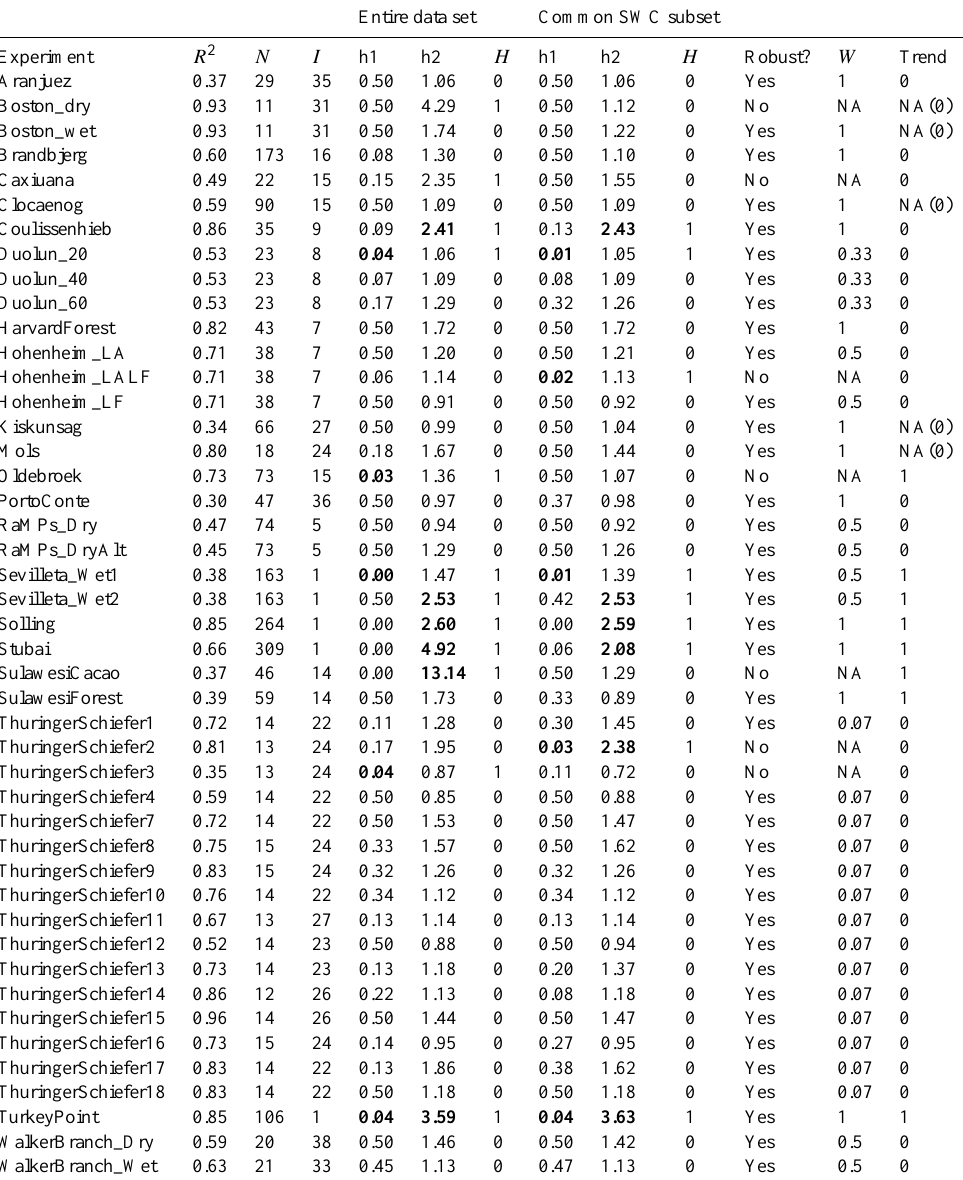
Table C1. For each experiment, we present the R 2 of the model fitted to the data of the control plots, the number of data points (N) and the median interval (in days) between two consecutive measurements of soil CO 2 efflux (I). We also show the results of the two tests that we performed to test our hypothesis. For both the entire data set and the common SWC subset, “h1” is the p value of the Lilliefors test for normality, “h2” shows the ratio of RMSE treatment to RMSE control and “H” indicates whether or not H1 was rejected (see Fig. 2 and Methods for details). Experiments for which both the entire data set and the common SWC subset gave the same result are indicated with “yes” in the column “Robust?”. The weight ( W ) used in this CART analysis is given ( W is calculated as 1/number of experiments per site that are used in CART). The results of the trend analysis on the time course of the predictability index of SCE treatment (Pi, runs test dichotomized around the median) are presented in the column “Trend”, with 0 indicating that no trend was detected and 1 indicating a significant trend for Pi versus time. When the rainfall manipulation was initiated more than one year before the start of SCE measurements, trend analysis is considered irrelevant. This is indicated as NA, followed by the result of the trend analysis in parentheses. Note that this table includes only results for experiments with >10 data points and for which residuals of the control were normally distributed. Values in bold highlight the reason for rejecting